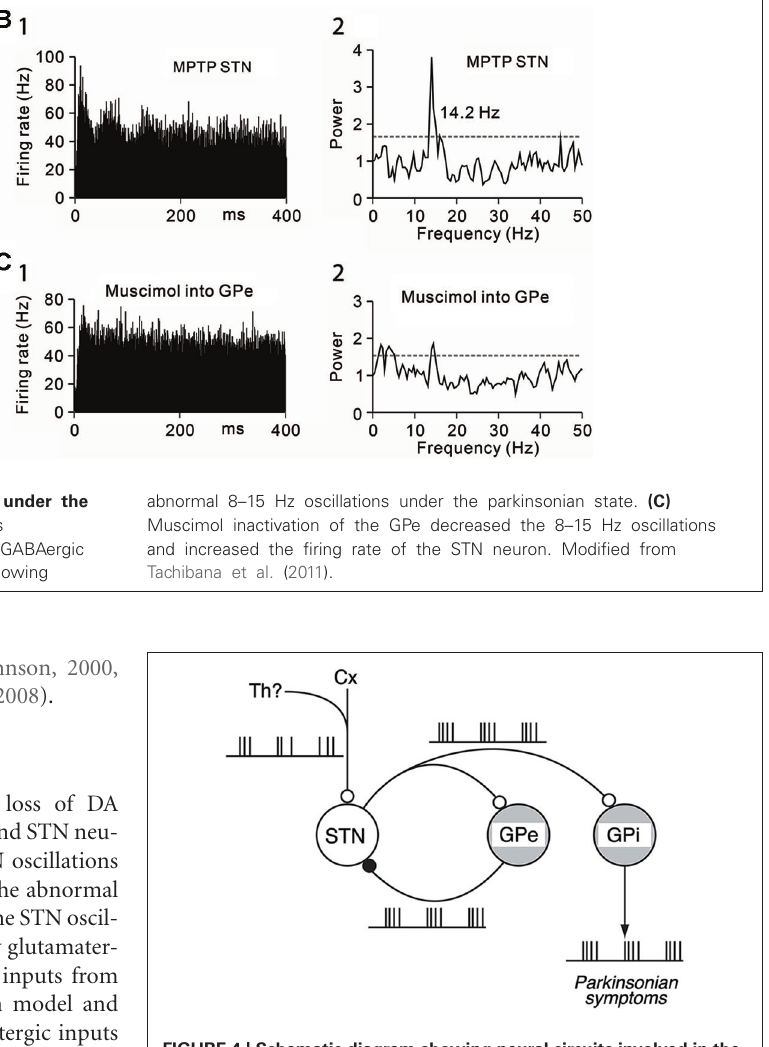
FIGURE 4 | Schematic diagram showing neural circuits involved in the generation of BG oscillations . Under the parkinsonian sate, glutamatergic inputs from the Cx (and also from the Th) to the STN and reciprocal GPe-STN interconnections can cooperatively generate and amplify the oscillatory activity of STN and GPe neurons. Such oscillatory activity is subsequently transmitted to the GPi, contributing to the expression of parkinsonian symptoms. Open and filled circles represent glutamatergic and GABAergic synapses, respectively. Modified from Tachibana et al.